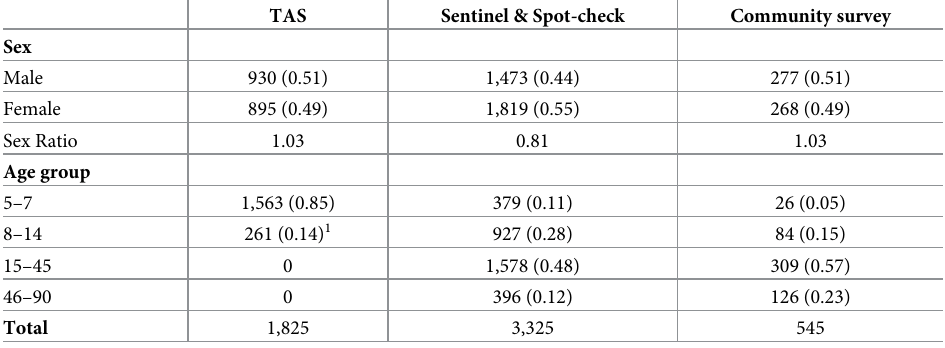
Table 2. Demographic characteristics of study participants at each of the three surveys. TAS Sentinel & Spot-check Community